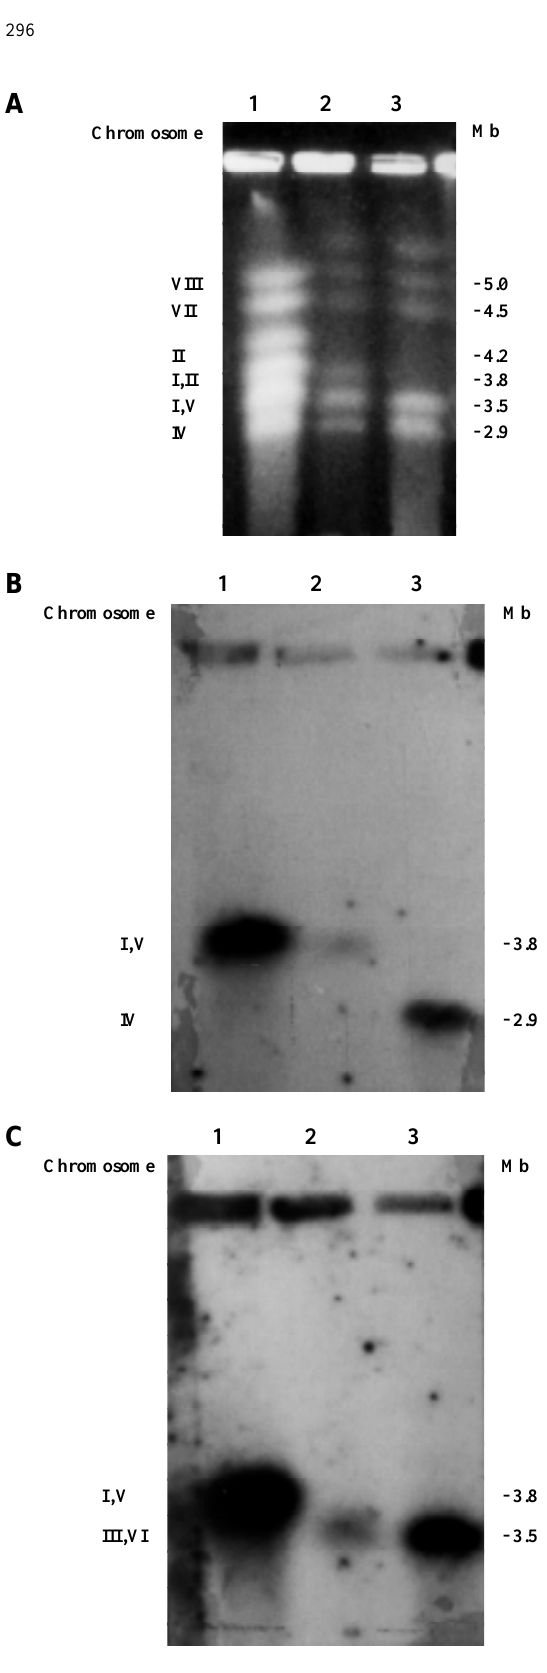
Figure 2 - Separation of Aspergillus nidulans intact chromosomal DNA on a CHEF gel (2A). The DNA was isolated from MSE (lane 1), strain A (lane 2) and strain V5 (lane 3). B and C, the same DNA samples probed with labeled genes pyr G and hx A,